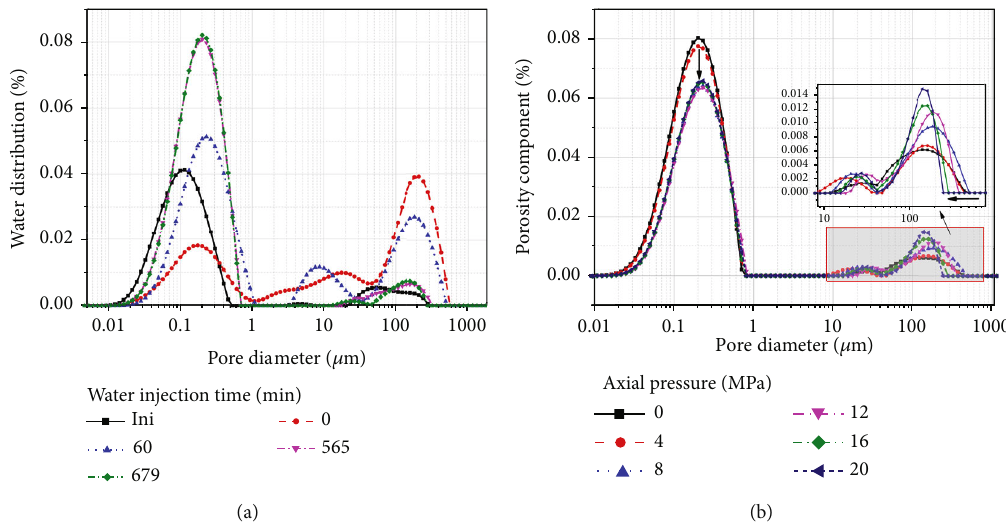
Figure 12: The PSD variation of sample. (a) Water amount during water injection. (b) Porosity during the compression